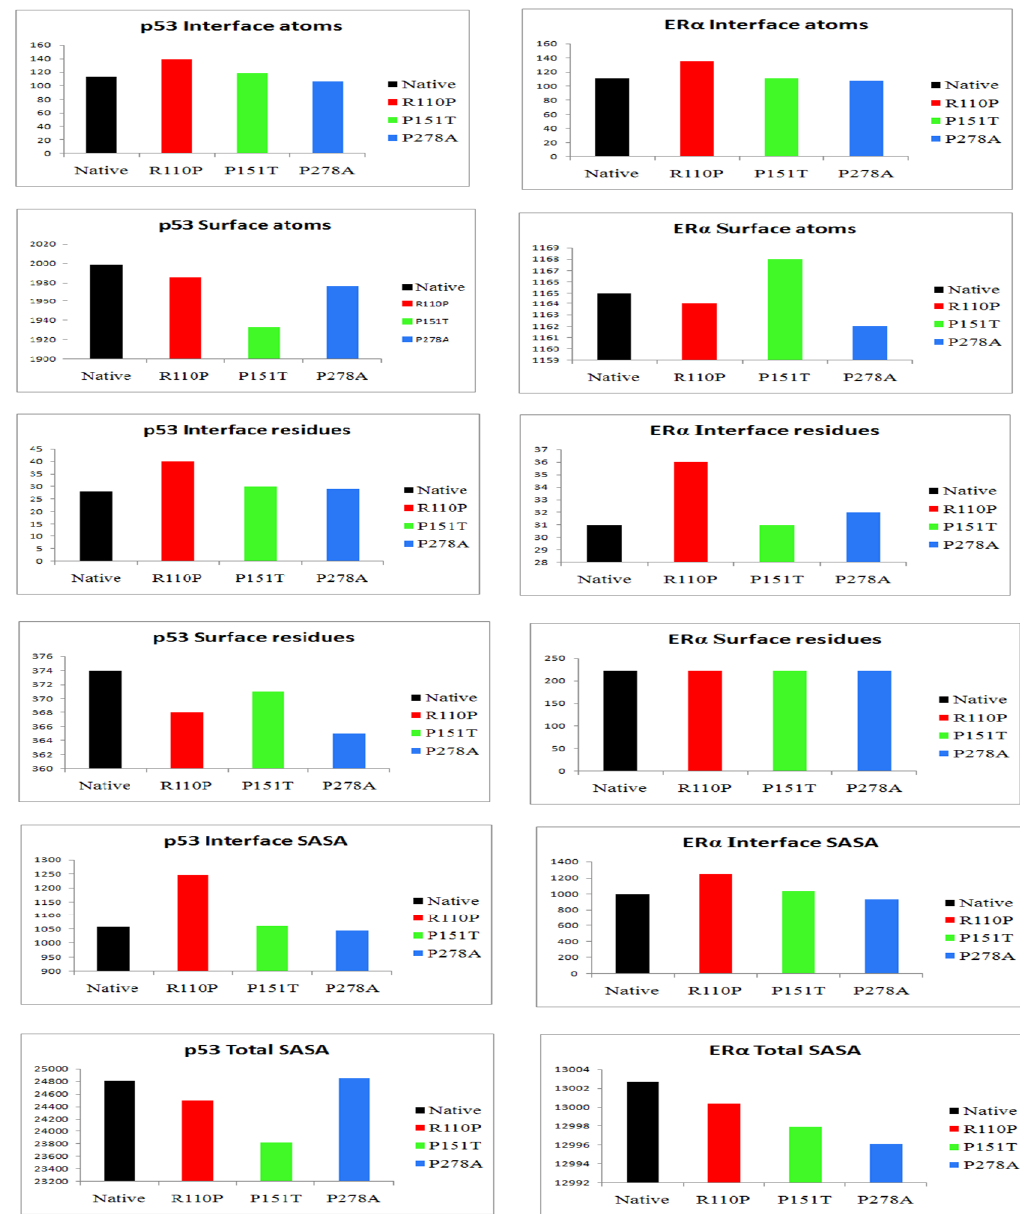
Figure 3. Surface, interface and solvent accessible surface analysis of the impact of three mutants R110P, P151T and P278A on the p53–ER α interaction. Black: native or WT, Red: R110P, Green: P151T, Blue: P278A.